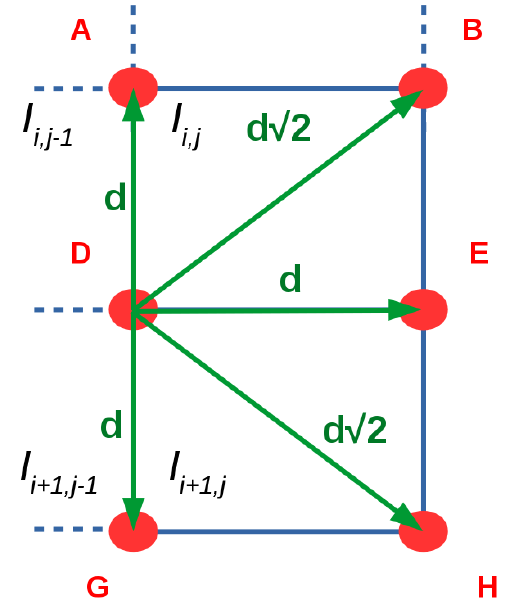
Fig. 14. Parametrization of the image I , assuming that the crack only propagates forward (to the right), in order to cre- ate the graph G and the adjacency matrix A for Dijkstra’s